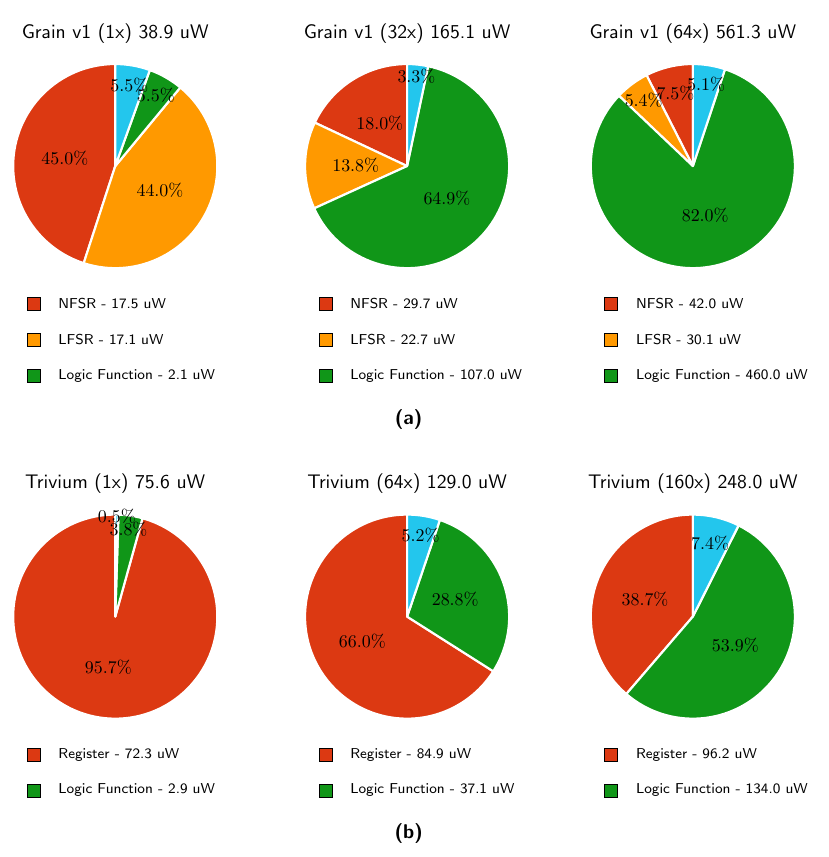
Figure 5: Power consumption shares of Grain v1 for 1, 32, 64 degrees of unrolling, Trivium for 1, 64, 160 degrees of unrolling (the sectors in blue denote power consumed in counters, and other control